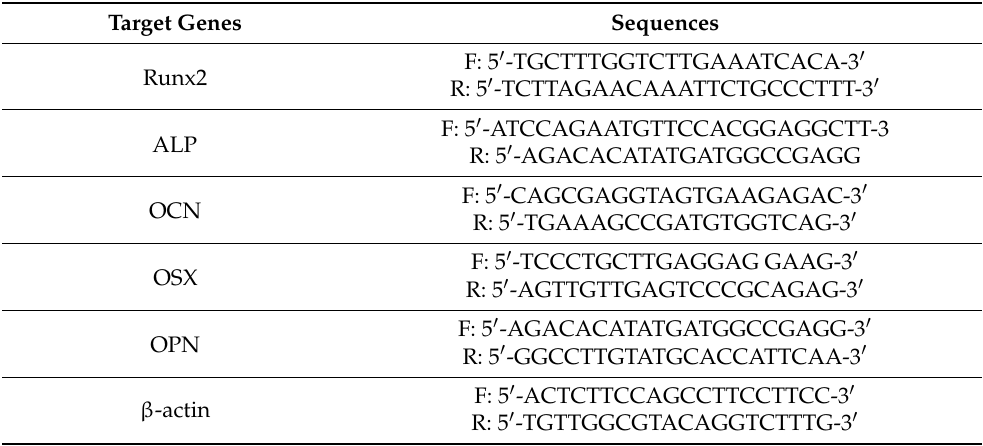
Table 2. Primer sequences used for real-time